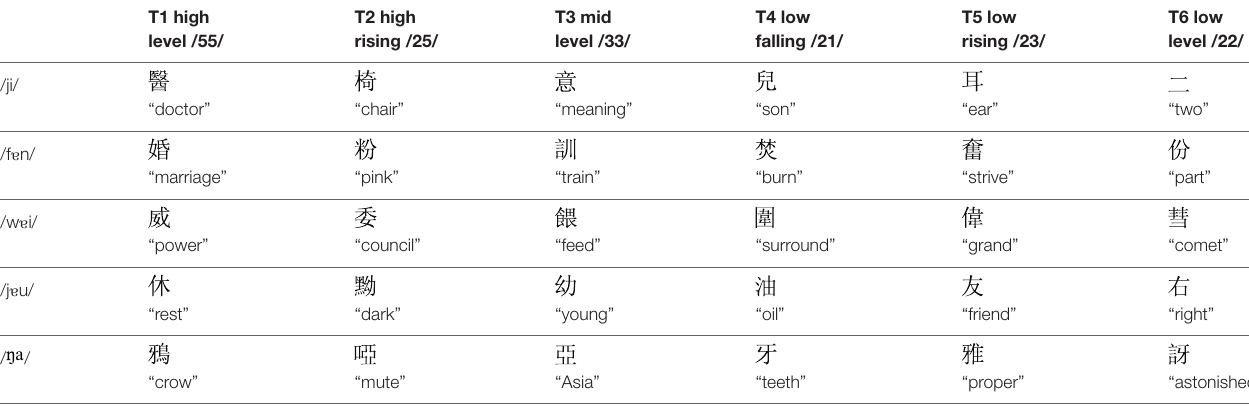
TABLE 2 | The five sets of syllables used in the